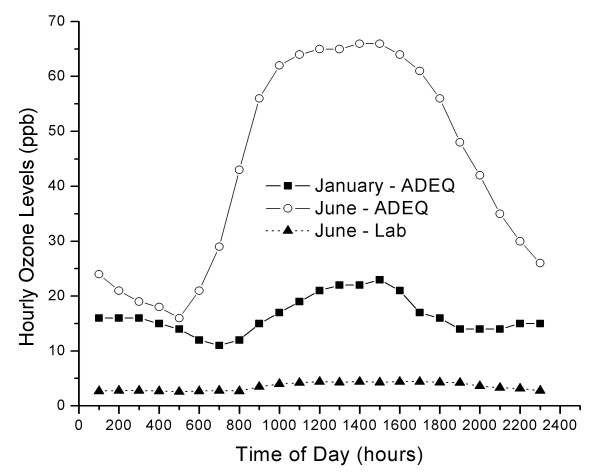
Diurnal ozone fluctuations. The means of hourly atmospheric ozone levels measured during January and June 2005 in central Arkansas by the ADEQ along with carbon-filtered laboratory air are shown. Peak ozone concentrations averaged 56–66 ppb between 0900 and 1800. Hourly ozone levels during this period commonly reached 60–90 ppb with the highest level reaching 103 ppb. By contrast, laboratory ozone levels varied between 2.6 and 4.4 ppb after installation of the carbon-filtered air supply.